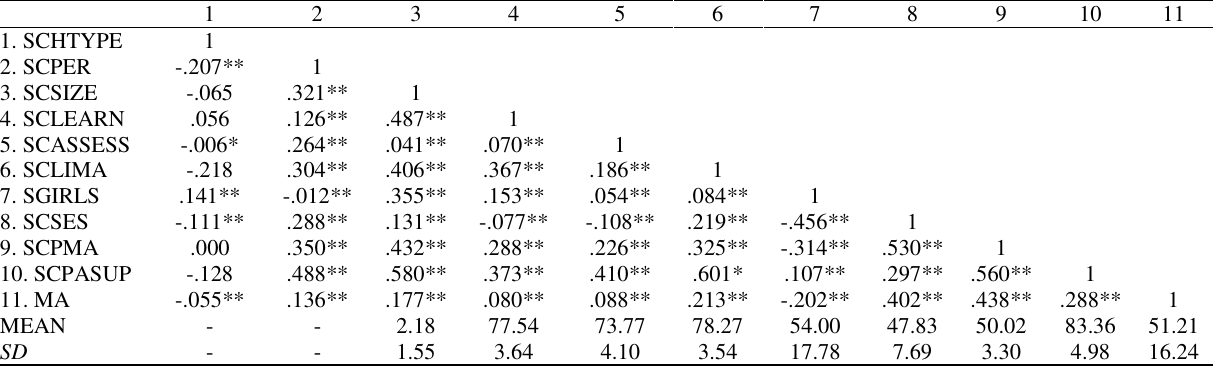
Table B3 School-level predictors and mathematics achievement for the total school sample ( N =